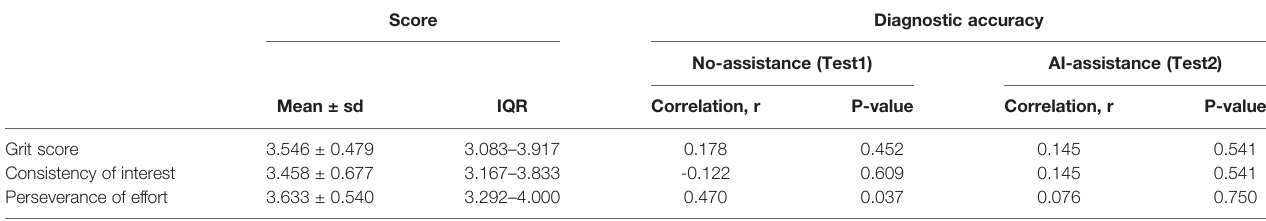
Sd, standard deviation; IQR, interquartile